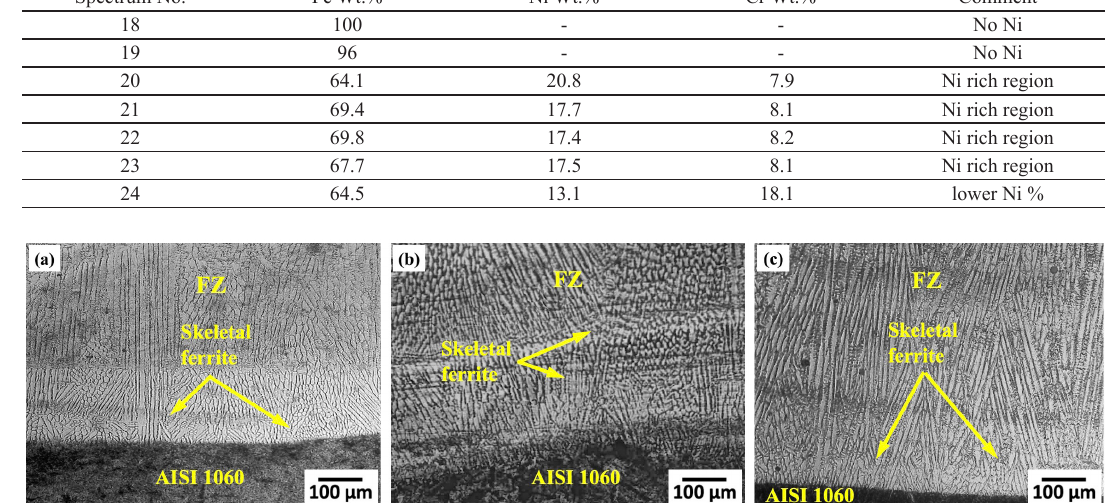
Figure 4. Microphotography of areas adjacent to fusion boundary at carbon steel side with different welding conditions (a) 600A, 0.3s, no Ni (b) 600A, 0.3s, with Ni (c) 800A, 0.3s, with Ni.